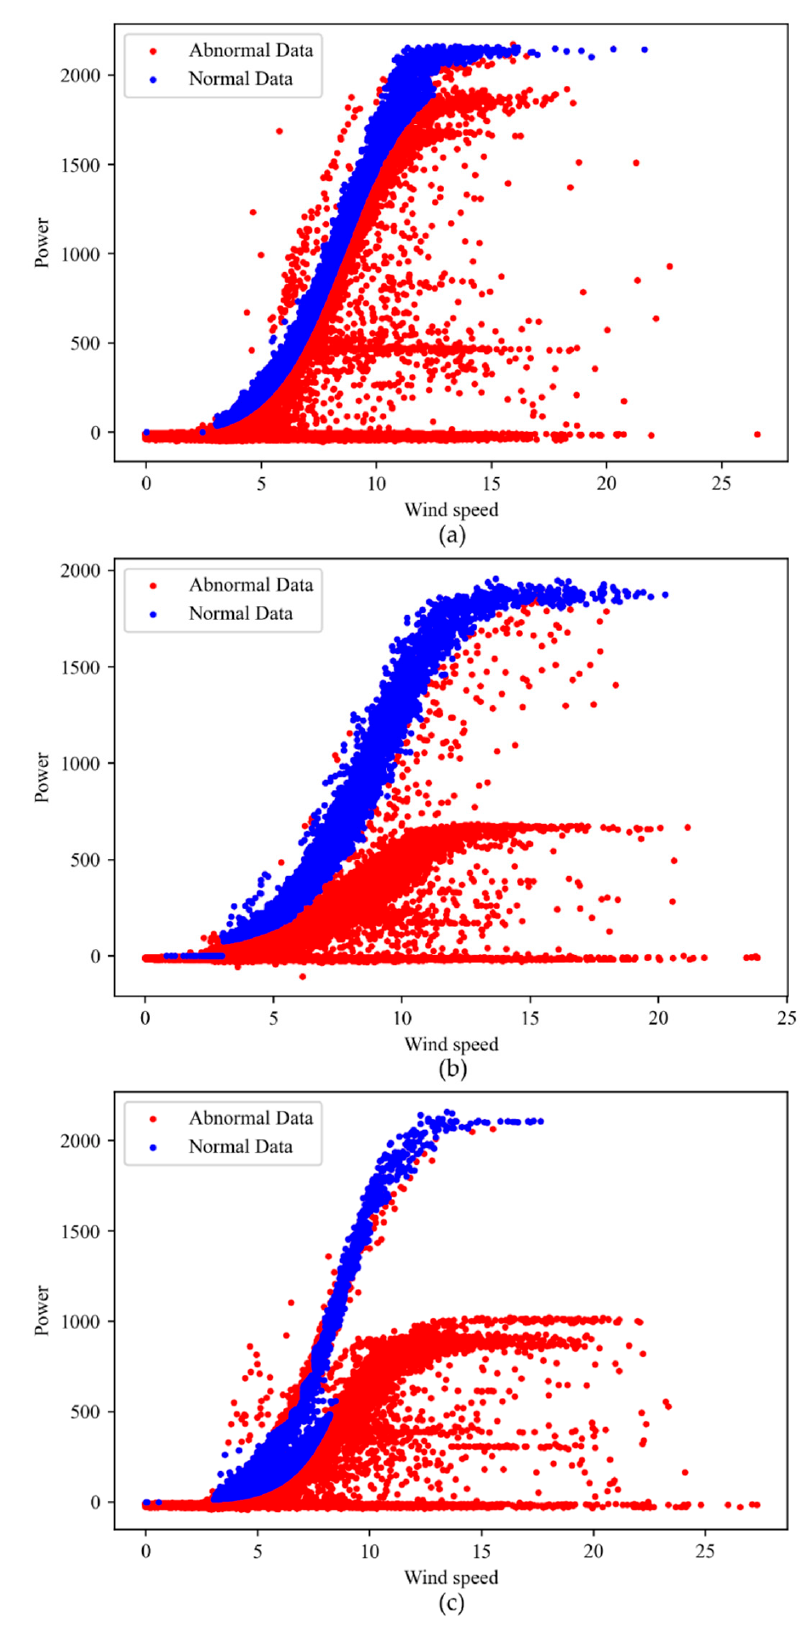
Figure 9. Abnormal data cleaning method for wind turbines based on constrained curve fitting: ( a ) #1 wind turbine; ( b ) #2 wind turbine; ( c ) #3 wind turbine.